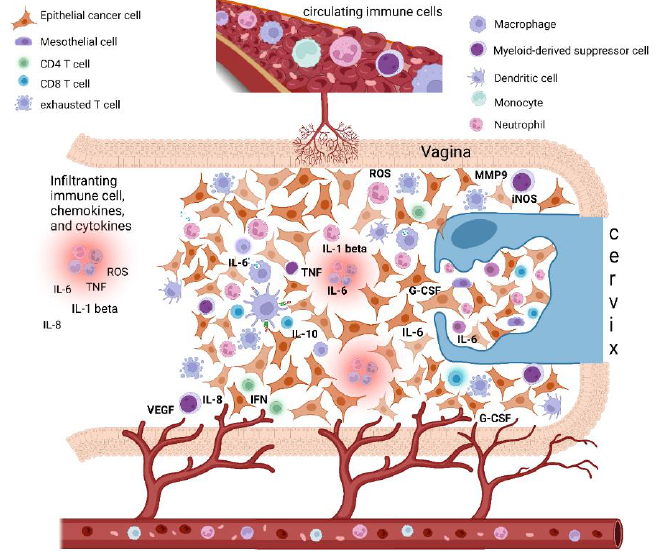
Figure 1. Epithelial cervical cancer microenvironment, tumor-associated inflammation, and para- neoplastic leukocytosis. The cervical cancer tumor microenvironment (TME) is composed of dif- ferent cells, including epithelial cancer cells, fibroblasts, mesenchymal cells, and immune cells, i.e., macrophages, mast cells, dendritic cells, and neutrophils, as well as T and B lymphocytes. Cancer- related inflammation can promote cancer progression by providing bioactive molecules to the TME, inclusive of growth factors, survival factors, proangiogenic proteins (VEGF), extracellular-matrix- degrading enzymes (MMP-9) that enable angiogenesis, invasion, and metastasis. These signaling molecules are released by the immune inflammatory cells as well as by cancer cells themselves. Moreover, during inflammation, immune cells can release several cytokines and chemokines (IL-6, IL-1beta, TNF-alpha, IL-8, INF-gamma) as well as a large amount of ROS as defense agents and products of hyperactivated energy metabolism. In turn, cytokines engage innate immune cells, mainly macrophages and neutrophils, that finally promote tumor growth and immune-suppressive status favoring tumor escape. In this context, cervical cancer tumors may also tend to promote myelopoiesis and sustain an increase in leukocytosis. This event seems to be mediated by the production in the TME of specific cytokines as a G-CSF and IL-6, both by cancer cells and TME inflammatory infiltrate. Beside inducing myelopoiesis, these factors can also promote the assembling in TME of immature myeloid progenitors known as myeloid-derived suppressor cells (MDSCs), which are able to directly promote tumor progression, in particular angiogenesis, and also suppress cytotoxic T lymphocyte and natural killer (NK) cell activity, thus contributing to immune escape. Abbreviations: IL, interleukin; TNF, tumor necrosis factor; IFN, interferon; ROS, reactive oxygen species; iNOS, inducible nitric oxide synthase; MMP, metalloproteinase; G-CSF, granulocyte-colony stimulating factor; VEGF, vascular endothelial growth factor. Created with